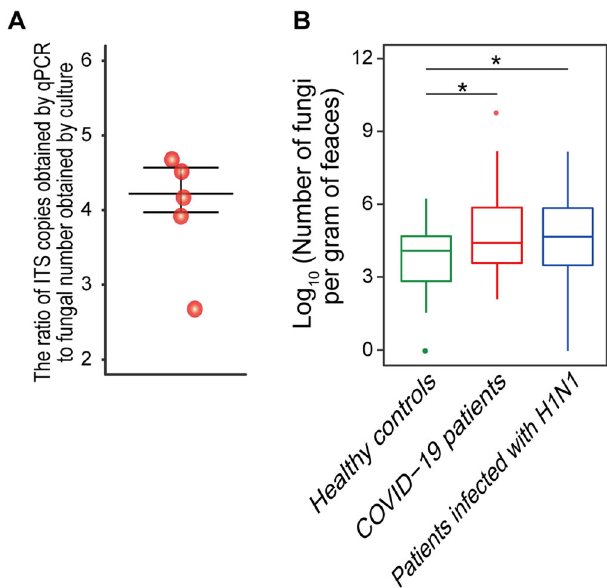
Fig. 4 Fungal burden increased in the gut of H1N1-infected patients and COVID-19 patients. A The ratio of ITS copies of Clavispora lusitaniae CICC 32908 obtained by qPCR to CICC 32908 number obtained by culture. The experiment was repeated fi ve times. B Number of fungi in one gram of faeces from the healthy controls ( n = 48), COVID-19 patients ( n = 67) or H1N1-infected patients ( n = 35). The ITS copies in the faeces obtained by qPCR were converted to fungal numbers based on the ratio of ITS copies of Clavispora lusitaniae CICC 32908 obtained by qPCR to CICC 32908 number obtained by culture. * P < 0.05; ** P < 0.01; and *** P <